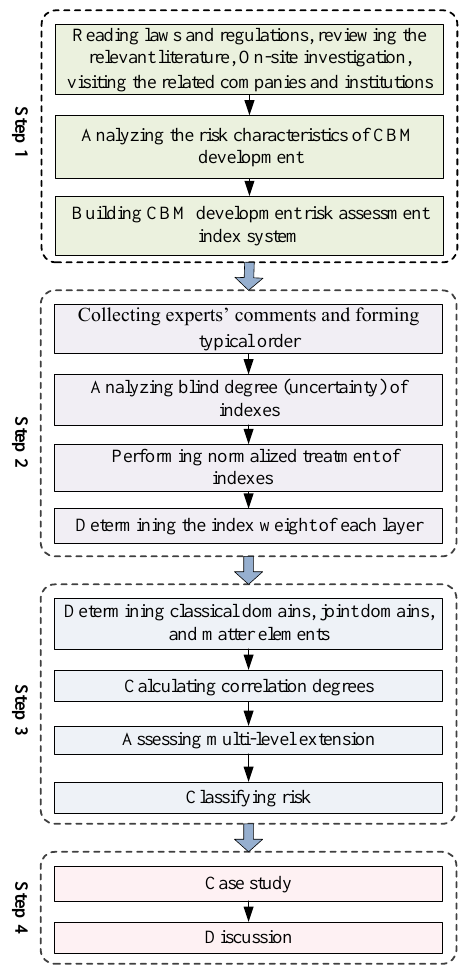
Figure 1. Steps of the present study. CBM, coalbed methane.